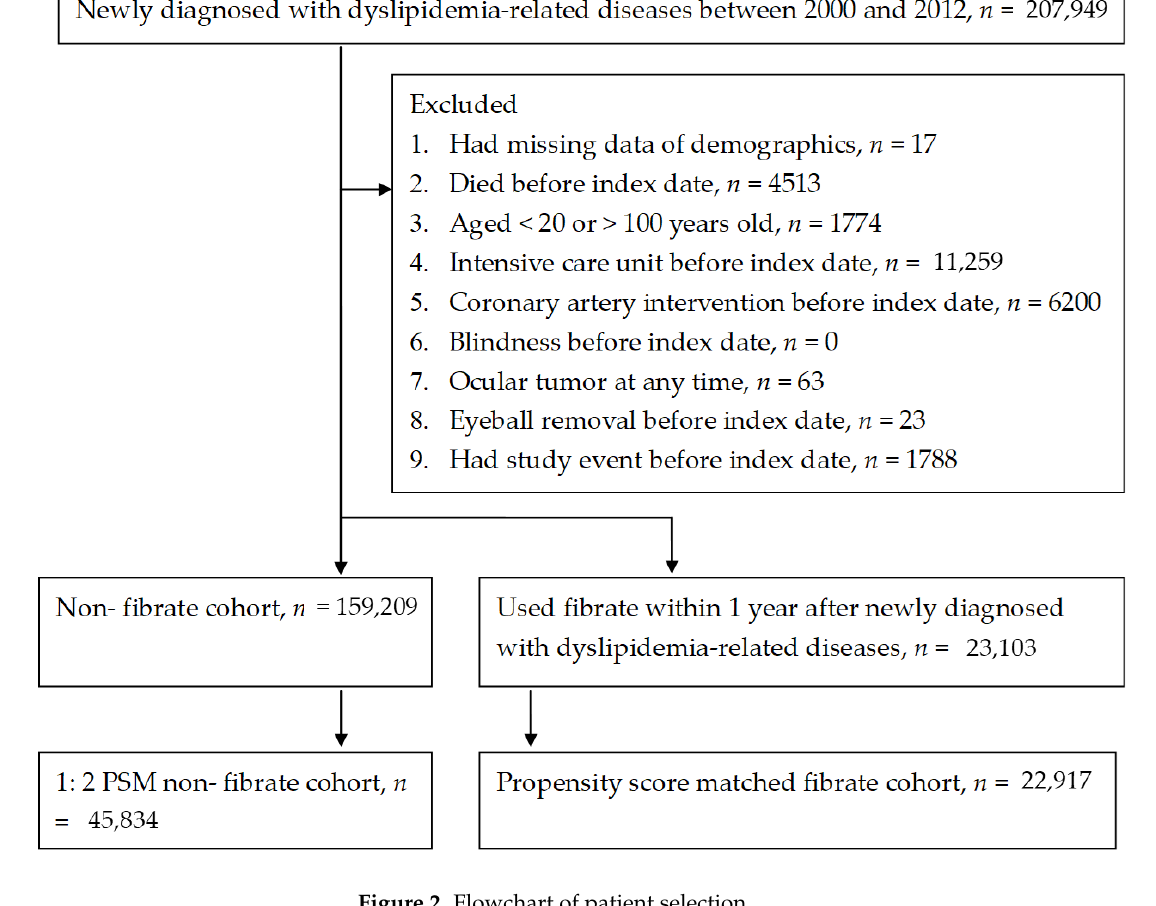
Figure 2. Flowchart of patient selection. Table 2. Characteristics among fibrate and non-fibrate group after propensity score matching. Characteristics